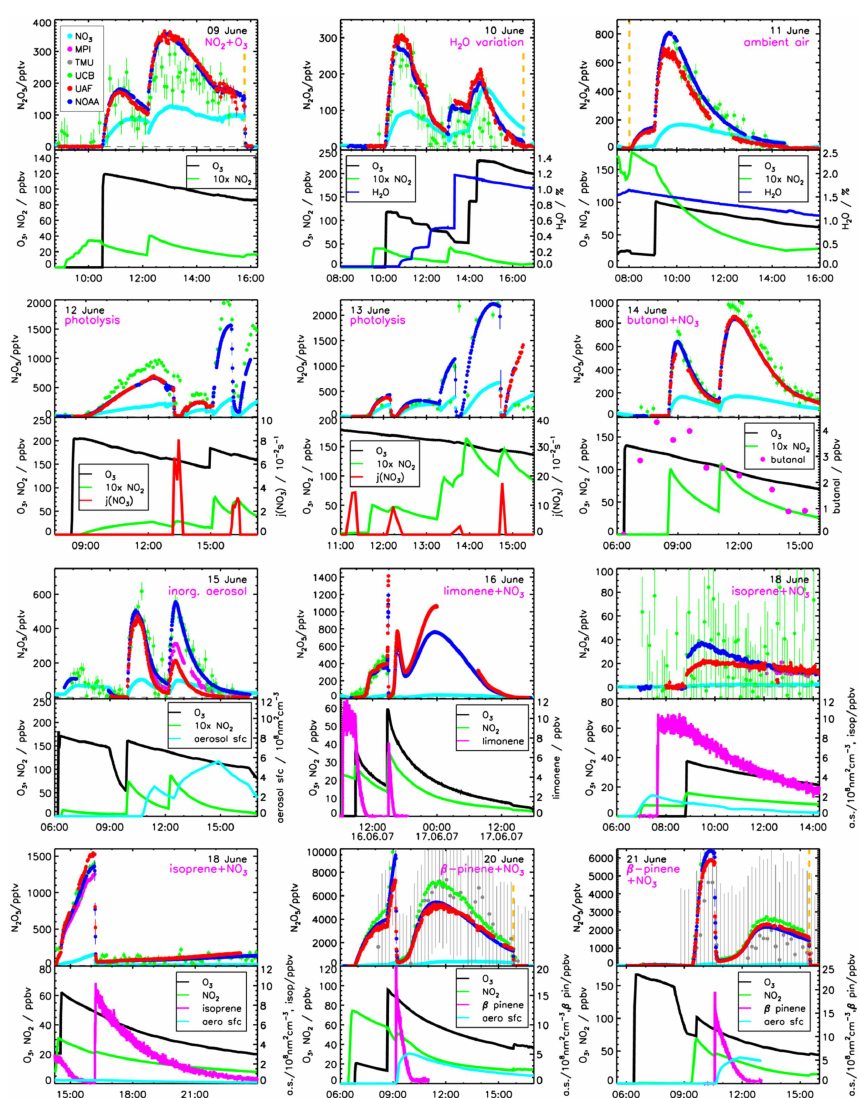
Fig. 1. Diurnal variation of N 2 O 5 mixing ratios (1min average) and compounds which were of importance during the experiment (aero sfc: aerosol surface concentration). NO 3 mixing ratios be NOAA-CRDS were taken to calculate N 2 O 5 mixing ratios from the sum measurement by MPI-CRDS, UCB-LIF, and TMU-LIF. The experiment on 18 June is divided into two panels, because N 2 O 5 mixing ratios were much higher during the second part of the experiment. Yellow dashed vertical lines indicate opening or closing of the chamber roof, if j( NO 3 ) is not